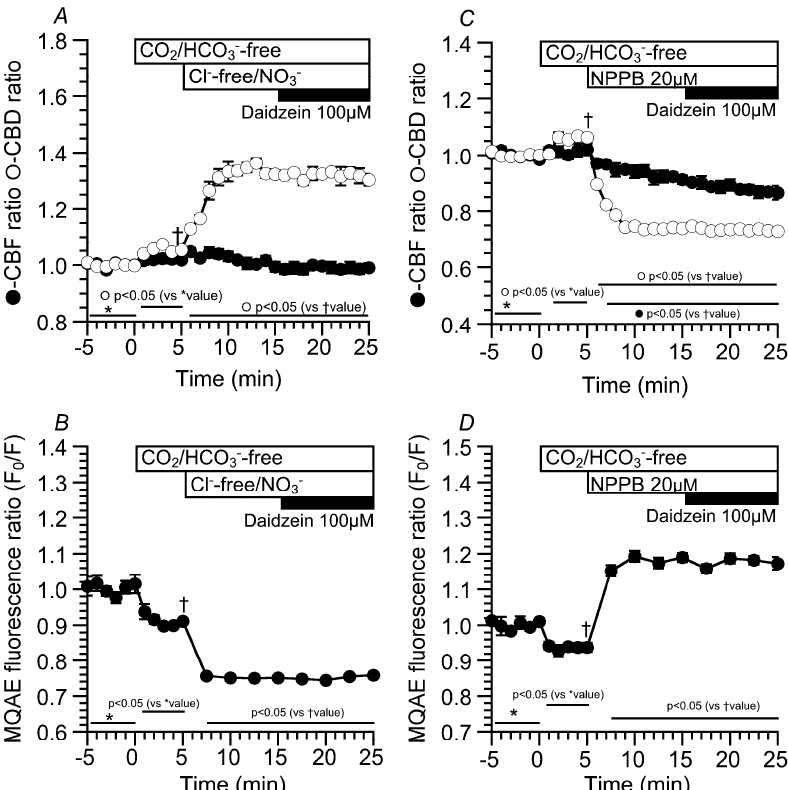
Figure 4. Effects of a low [Cl − ] i or a high [Cl − ] i on CBD and CBF in cHNECs. Experiments were carried out in the CO 2 /HCO 3 − -free control solution. To decrease the [Cl − ] i of cHNECs, a CO 2 /HCO 3 − -free Cl − -free NO 3 − solution was used ( A , B ). In contrast, to increase [Cl − ] i , NPPB was used ( C , D ). ( A ) The values of the CBD and CBF ratios just before the switch to the Cl − -free NO 3 − solution were 1.05 ± 0.01 ( n = 5) and 1.02 ± 0.01 ( n = 8), respectively. The switch to the Cl − -free NO 3 − solution immediately increased CBD, but not CBF. The values of CBD and CBF 10 min after the switch were 1.32 ± 0.01 ( n = 5) and 0.99 ± 0.02 ( n = 8), respectively. Further stimulation with 100 µ M of daidzein did not change the CBD or CBF. ( B ) Decreases in the MQAE fluorescence ratio (F 0 /F) induced by the Cl − -free NO 3 − solution. Switch to the CO 2 /HCO 3 − -free control solution decreased F 0 /F (F 0 /F five min after the switch = 0.91 ± 0.01, n = 7). Subsequent switch to the Cl − -free NO 3 − solution decreased F 0 /F. The value of F 0 /F in the Cl − -free NO 3 − solution 10 min after the switch was 0.75 ± 0.01 ( n = 7). Further stimulation with 100 µ M of daidzein did not change F 0 /F. ( C ) Decreases in CBD and CBF induced by NPPB. The values of CBD and CBF just before the addition of NPPB were 1.06 ± 0.01 ( n = 5) and 1.02 ± 0.02 ( n = 5), respectively. The addition of 20 µ M of NPPB immediately decreased CBD and gradually decreased CBF. The values of CBD and CBF 10 min after NPPB addition were 0.74 ± 0.01 ( n = 5) and 0.94 ± 0.02 ( n = 5), respectively. The CBF decreased by NPPB alone reached a plateau within 20 min (CBF 20 min after NPPB addition = 0.88 ± 0.02 ( n = 6, data not shown)). Further stimulation with 100 µ M of daidzein did not affect CBD, but gradually decreased CBF. The values of CBD and CBF 10 min after daidzein stimulation were 0.73 ± 0.01 ( n = 5) and 0.87 ± 0.02 ( n = 5), respectively. ( D ) Increases in the MQAE fluorescence ratio (F 0 /F) induced by NPPB. The value of F 0 /F in the CO 2 /HCO 3 − -free control solution five min after the switch was 0.93 ± 0.01 ( n = 7). The addition of 20 µ M of NPPB increased F 0 /F (F 0 /F 10 min after NPPB addition = 1.19 ± 0.01, n = 7). Further stimulation with 100 µ M of daidzein did not change F 0 /F (F 0 /F 10 min after daidzein stimulation = 1.17 ± 0.02, n =